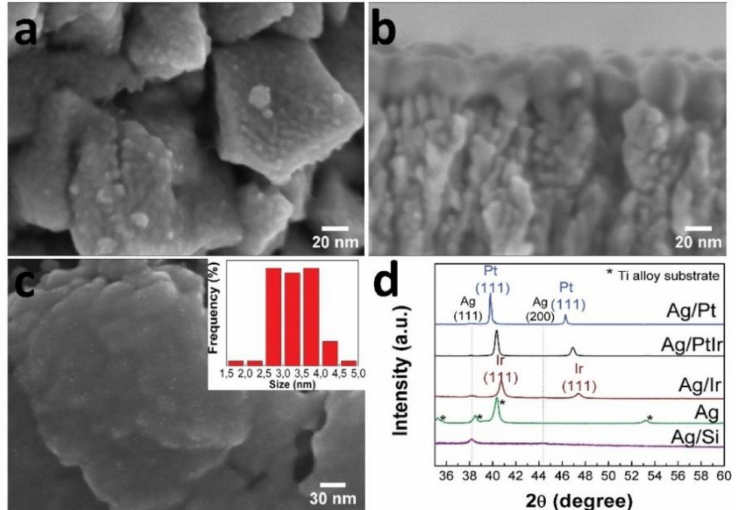
Figure 6. SEM micrographs of the surface of Ag/Pt sample ( a ) and cross-section of Ag/Ir sample ( b ), surface of Ag sample on Ti-alloy with AgNPs size distribution ( c ), and XRD patterns of series of Ag/Si, Ag, Ag/Ir, Ag/Pt, and Ag/PtIr samples ( d